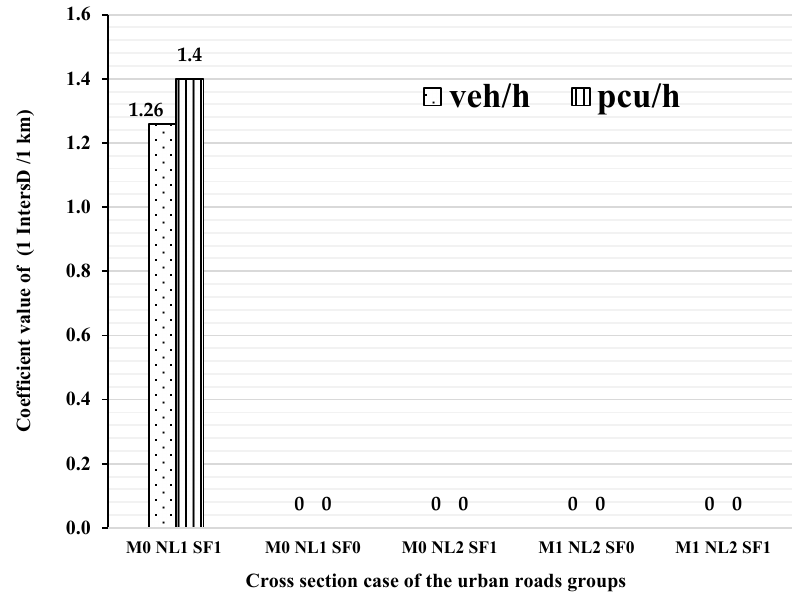
Figure 8. IntersD variation over the five developed models. The values of average travel speed (ATS) for the urban road category [M1, NL2, SF0] remained unaffected by the variation of three geometric parameters namely traffic calming speed density (TCSD), access driveway density (AccessD) and intersection density (IntersD) (Figures 6–8). However, the values of average travel speed (ATS) for the urban road category [M0, NL1, SF1] was appreciably impacted due to the variation of traffic calming speed density (TCSD) and intersection density (IntersD). Furthermore, for every 1 TCSD/km and 1 IntersD/km, the average travel speed (ATS) was reduced by 1.28 km/h and 1.26 km/h, respectively for the traffic volume in veh/h. Under the heterogeneous traffic (pcu/h) condition for every 1 TCSD/km and 1 IntersD/km, the average travel speed (ATS) value was decreased by 1.47 km/h and 1.4 km/h, respectively. On top, the access driveway density (AccessD) parameter has the highest impact on the average travel speed (ATS) value variation for the urban road category [M1, NL2,